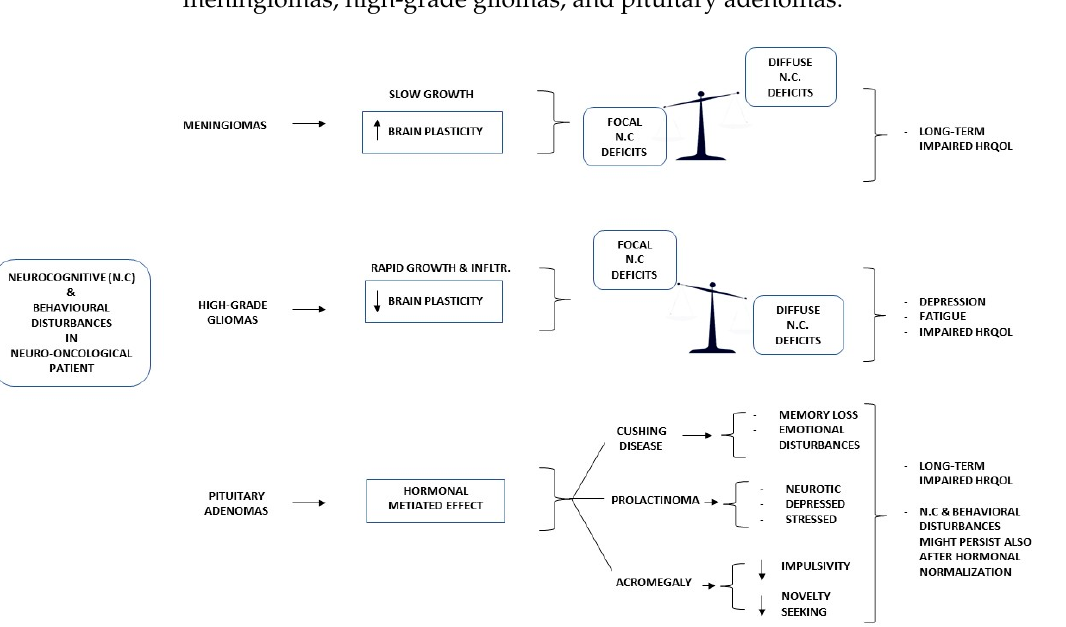
Figure 1. Neurocognitive and behavioral disturbances in relation to emotional distress and quality of life measures.